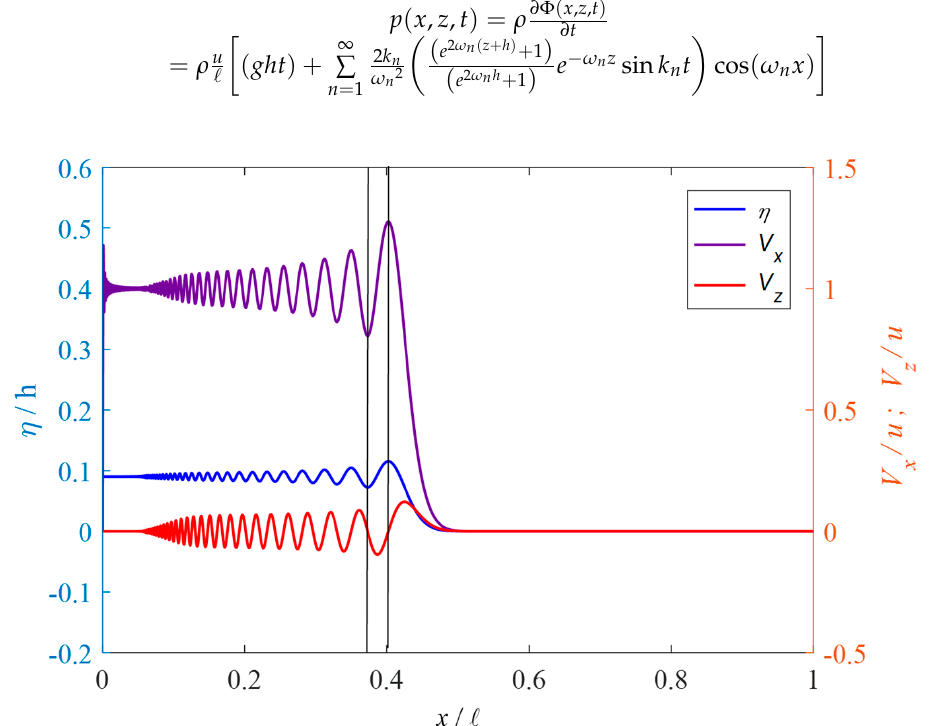
Figure 5. Surface elevation and flow velocities along the channel (inflow velocity 0.2 m/s and water depth 0.5 m).